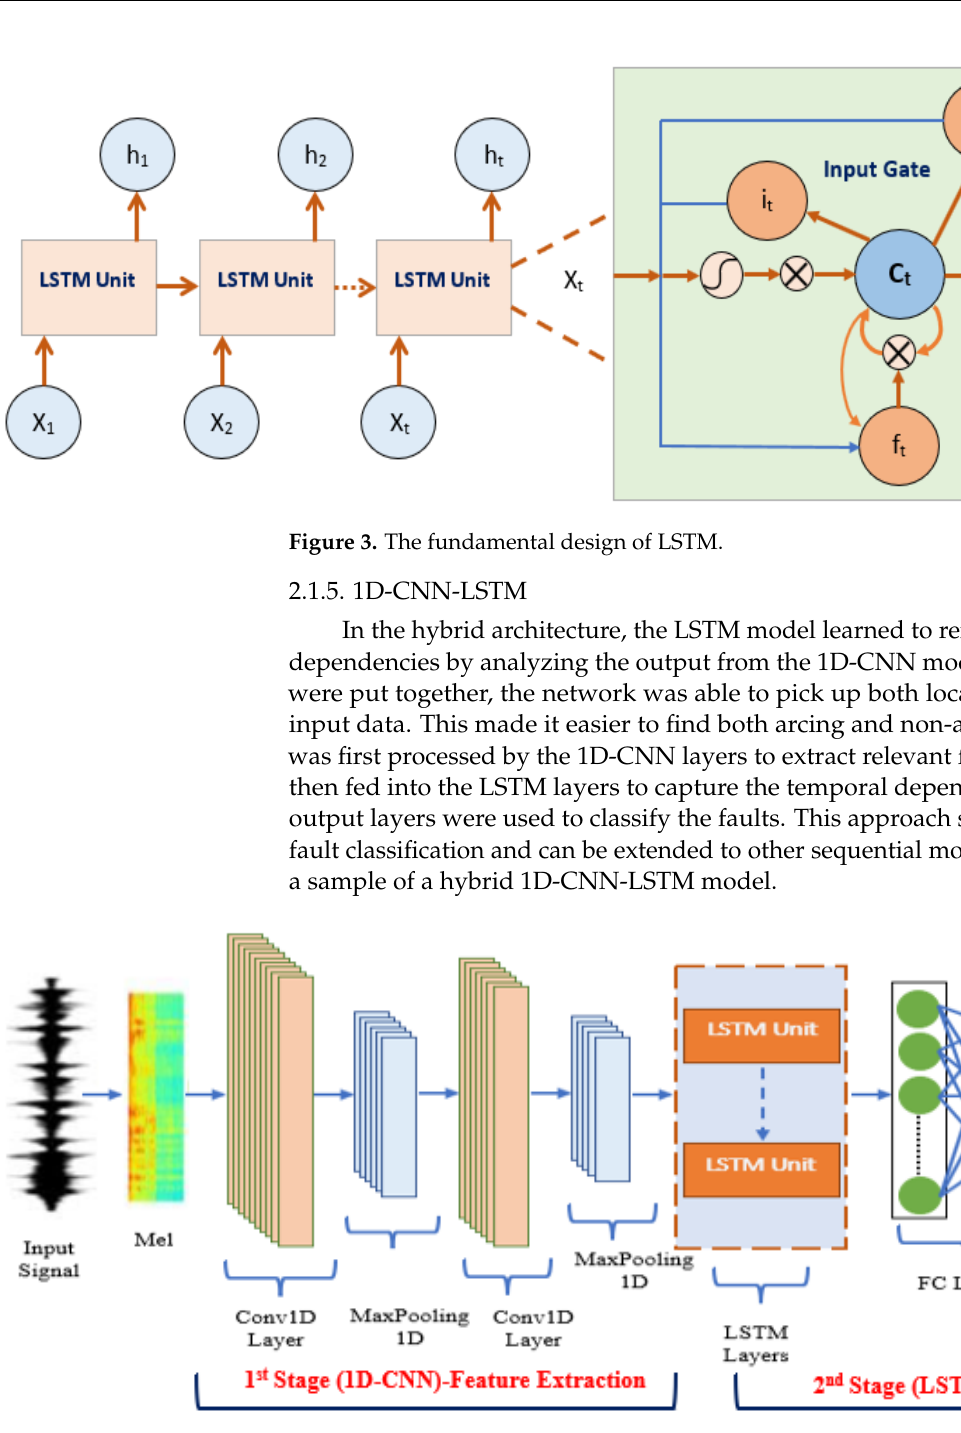
Figure 4. An instance of a 1D CNN-LSTM model.